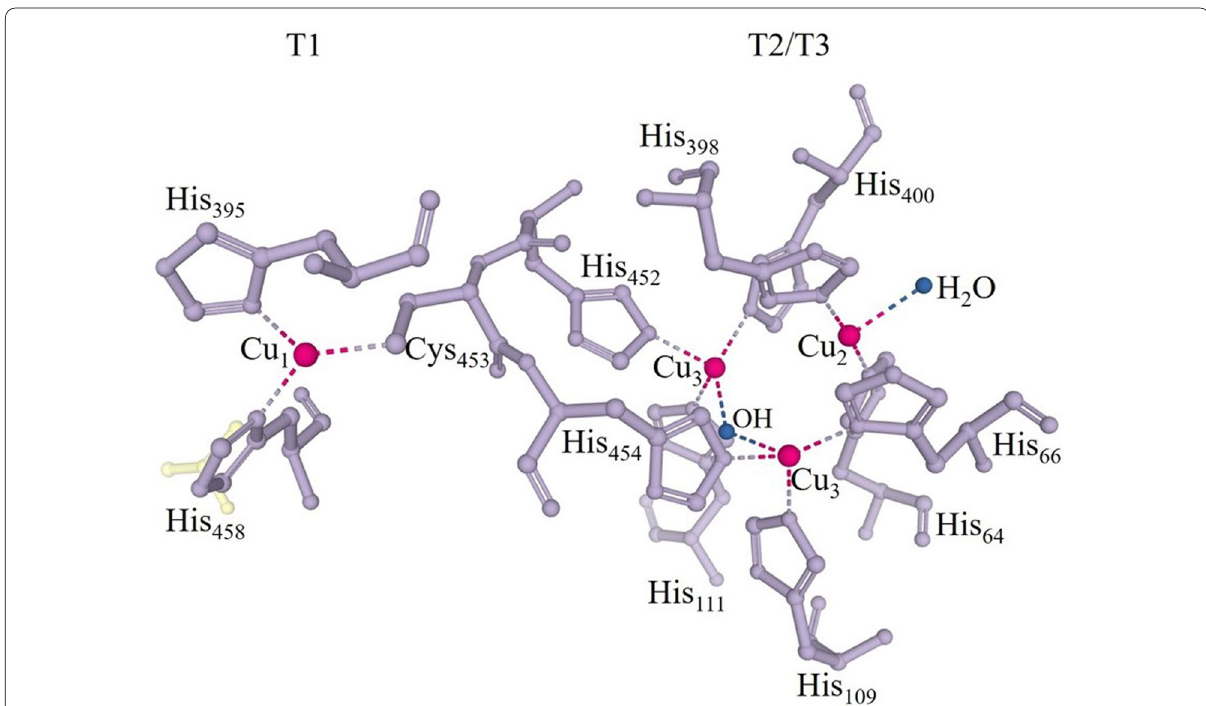
Fig. 1 Representation of the copper catalytic site of Trametes versicolor laccases (RCBS—Protein Data Bank code 1GYC) coordinated with different amino acids; acronyms indicate: His—histidines, Cys—cysteíne. The copper atoms are represented by pink